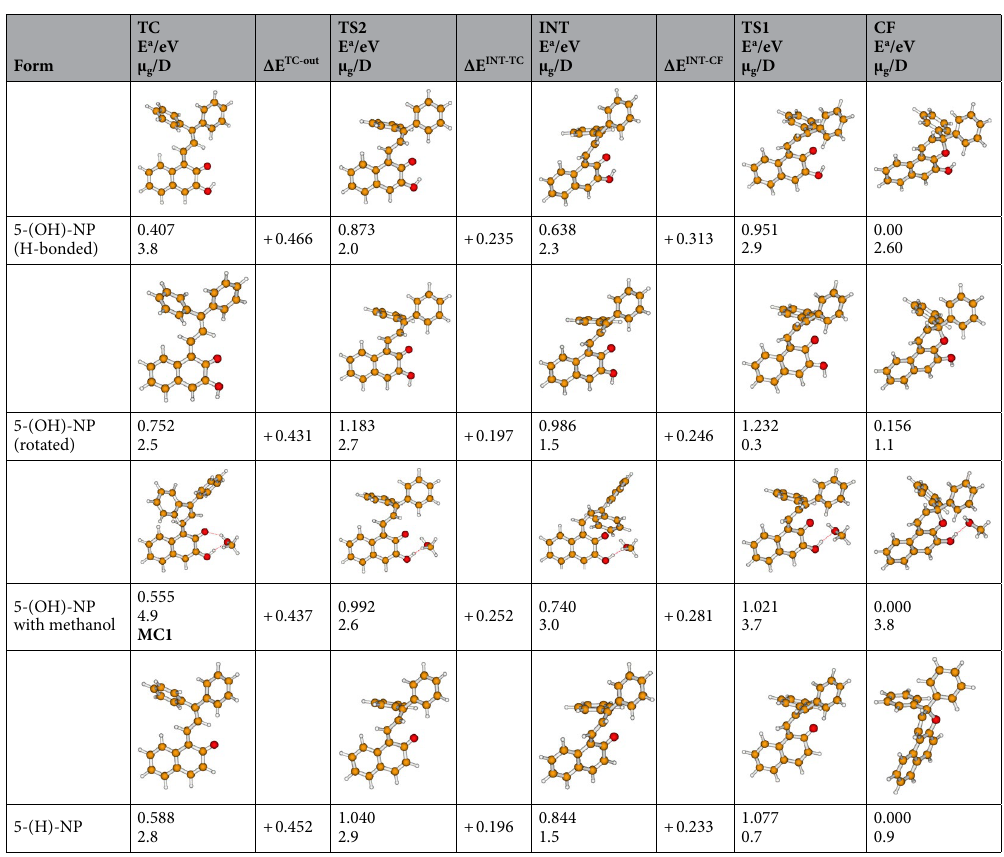
Table 2. Energetics of the two-step process of the TC form depopulation ( TC ↔ INT → CF ) for 5-(OH)-NP vs. 5-(H)-NP . Adiabatic S 0 -state energies, E a , in eV, and dipole moment, μ g , in Debye, for the relevant minima: TC , INT , CF , and transition states separating these minima: TS1 and TS2 , calculated at the MP2/cc-pVDZ theory level. Results for 5-(H)-NP are from reference 53